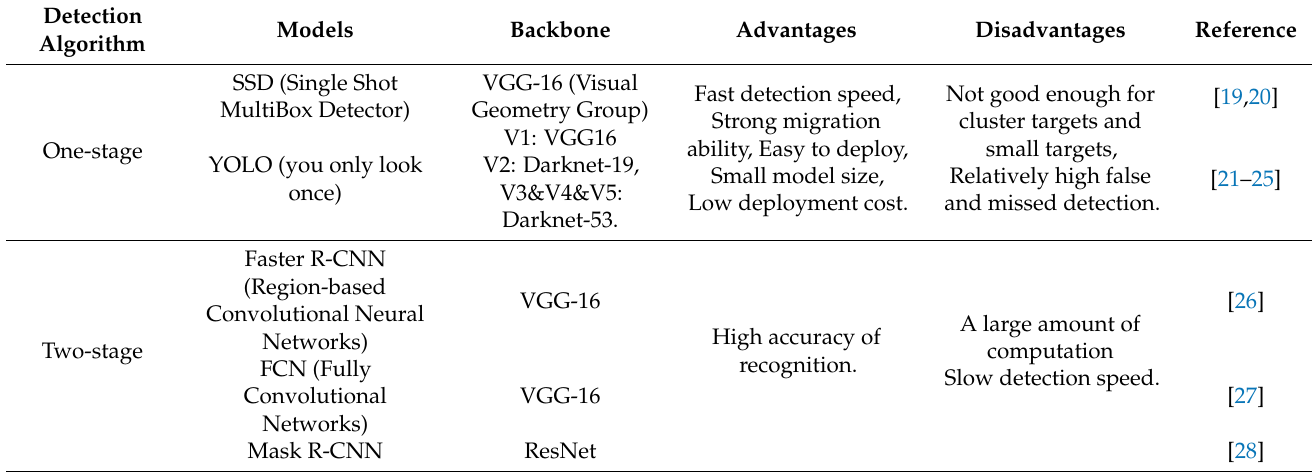
Table 1. Contrast between one-stage detection algorithm and two-stage detection